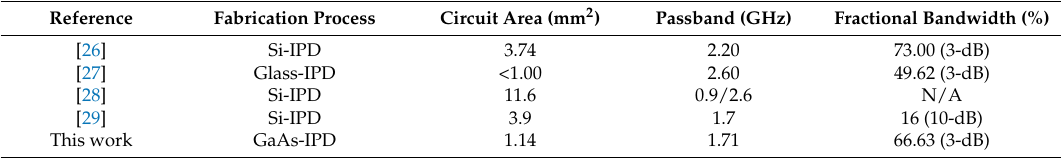
Table 5. Comparison of IPD BPF